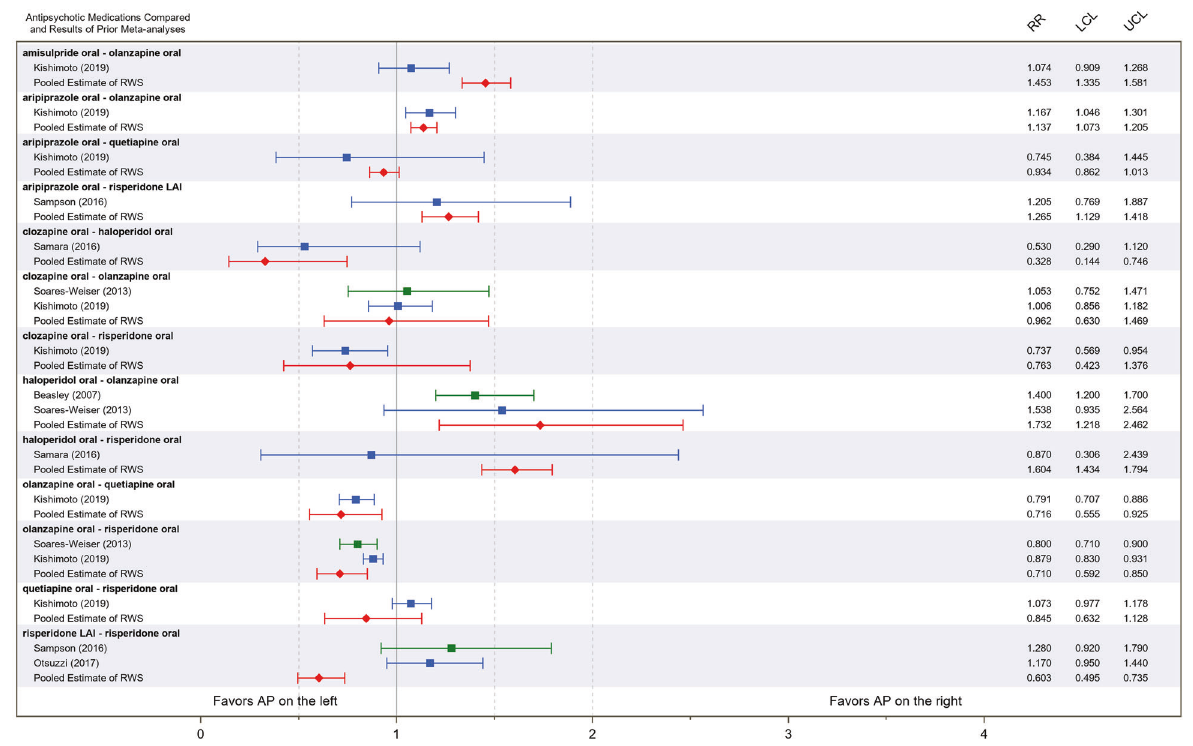
Fig. 3 Effect size estimates from previously published meta-analyses of RCTs, and from current meta-analysis. Outcome measure: treatment discontinuation due to any reason Groups: primary benchmark (blue); secondary benchmark (green); and pooled estimates of current meta-analysis (red). Please note that for the comparison of aripiprazole-quetiapine the pooled estimate RWS is only based on two studies. RR relative risk, LCL lower con fi dence limit, UCL upper con fi dence limit. Blue The results of individual meta-analyses based on randomized controlled trials ’ data considered as primary benchmark. Green The results of individual meta-analyses based on randomized controlled trials ’ data considered as secondary benchmark. Red Pooled estimates of current